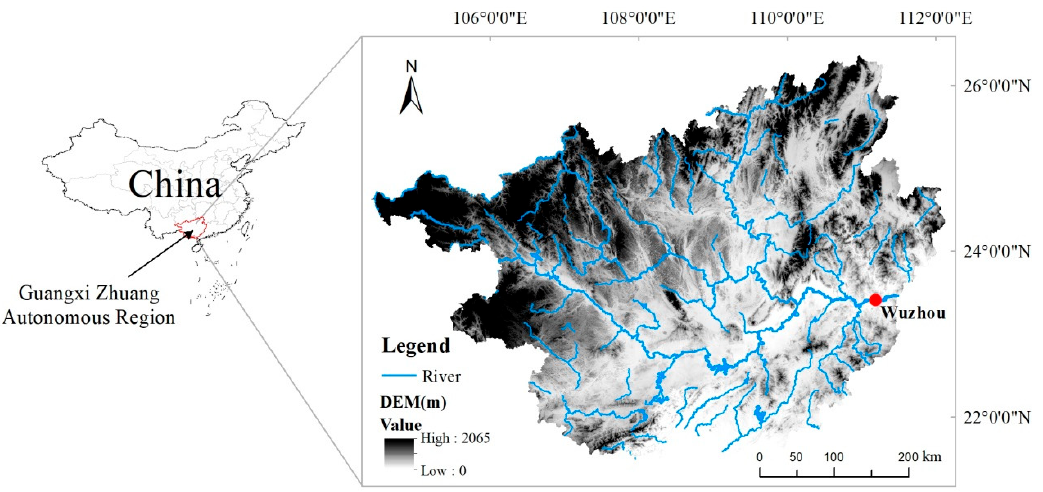
Figure 1. The location of Wuzhou City.